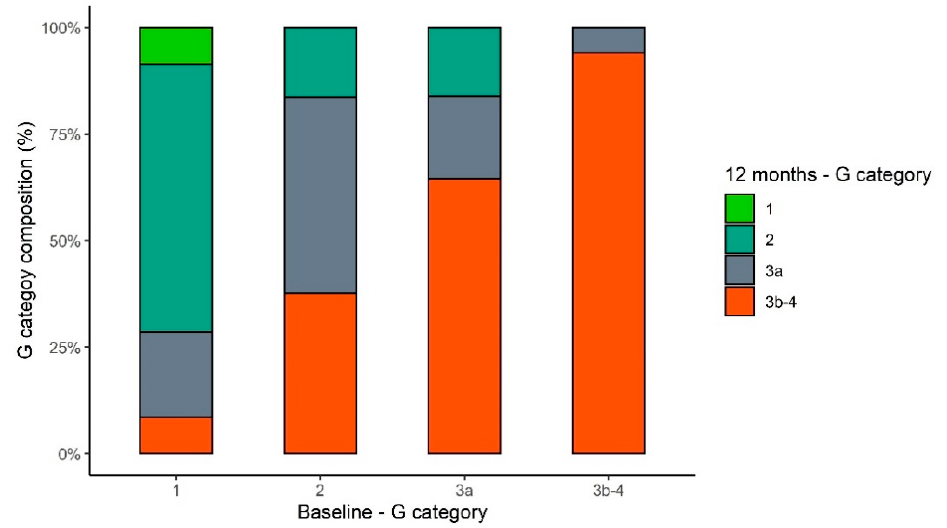
Figure 4. G category distribution after one year according to the baseline category.